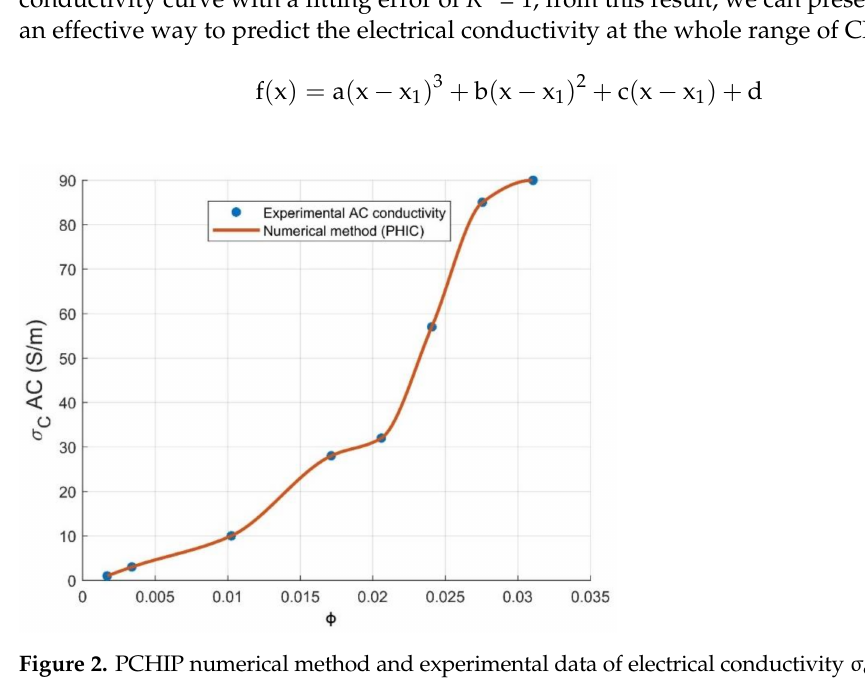
Figure 2. PCHIP numerical method and experimental data of electrical conductivity σ c for PC-CNT composites at several volume fraction of reinforcement φ